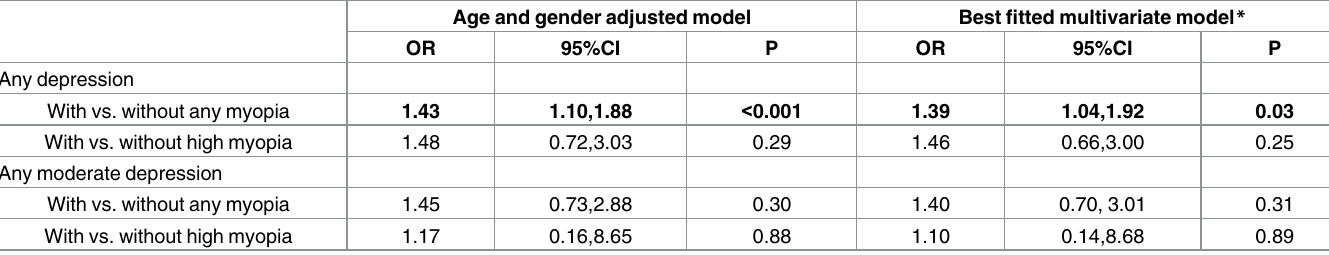
Table 2. Relationship of myopia and high myopia with depressivesymptoms.